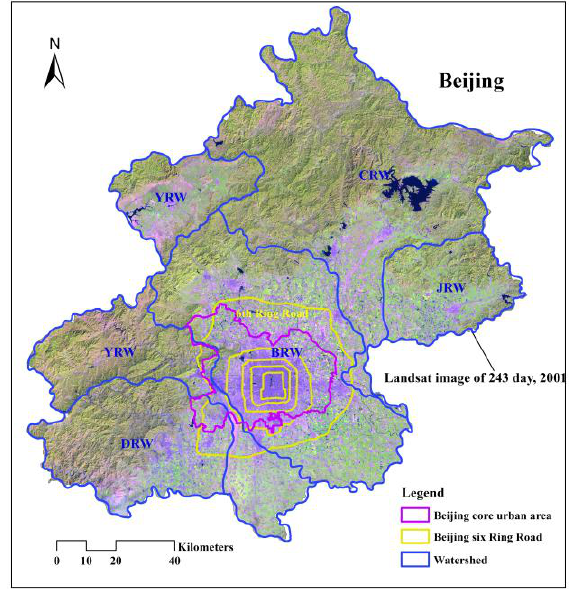
Figure 1. Map of study